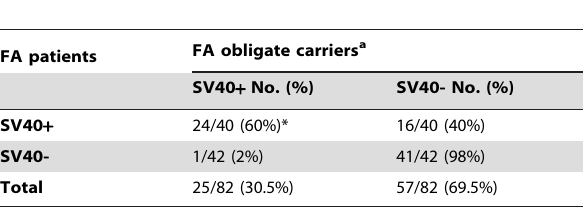
Table 2. SV40 infection in parents with respect to the presence of SV40 in their children.